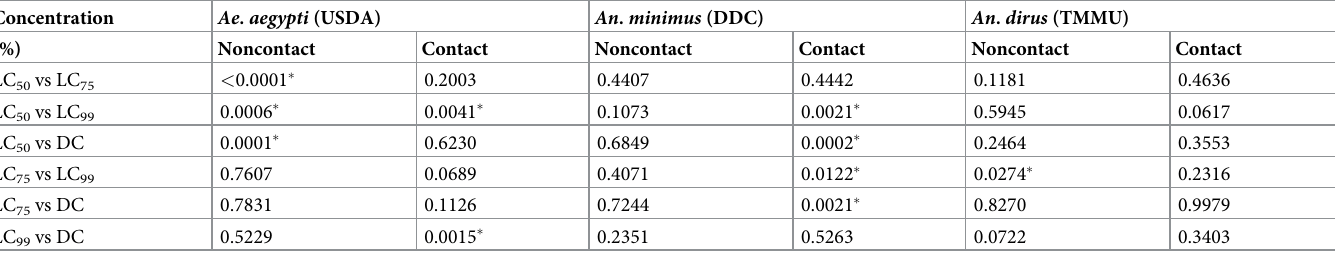
Table 5. Pairwise log-rank comparisons of mosquito escape responses between various transfluthin concentrations in noncontact and contact ER assays by species.